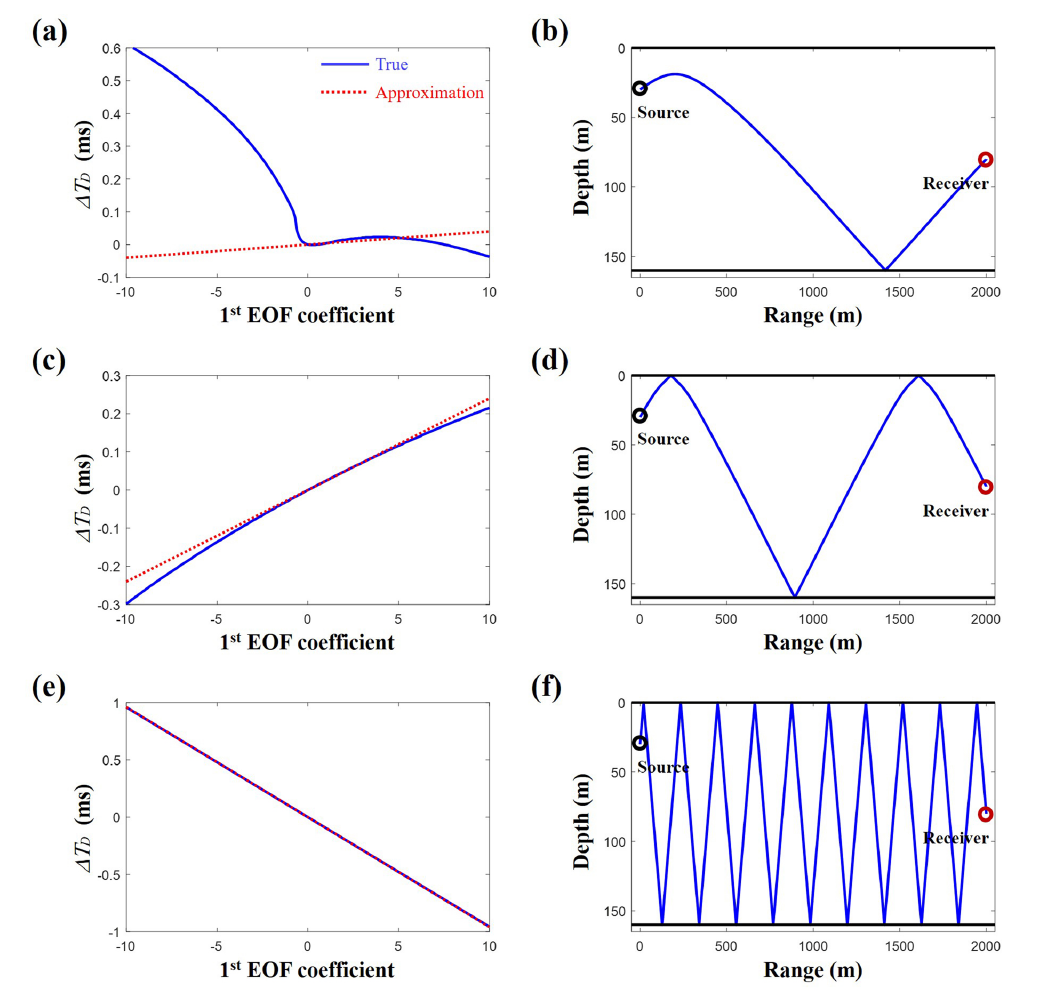
Figure 3. The differences in the vertical travel times at the source range for ( a ) low, ( c ) moderate, and ( e ) high arrival angles. The corresponding ray trajectories for the reference sound speed profile are shown in ( b ), ( d ), and ( f ),